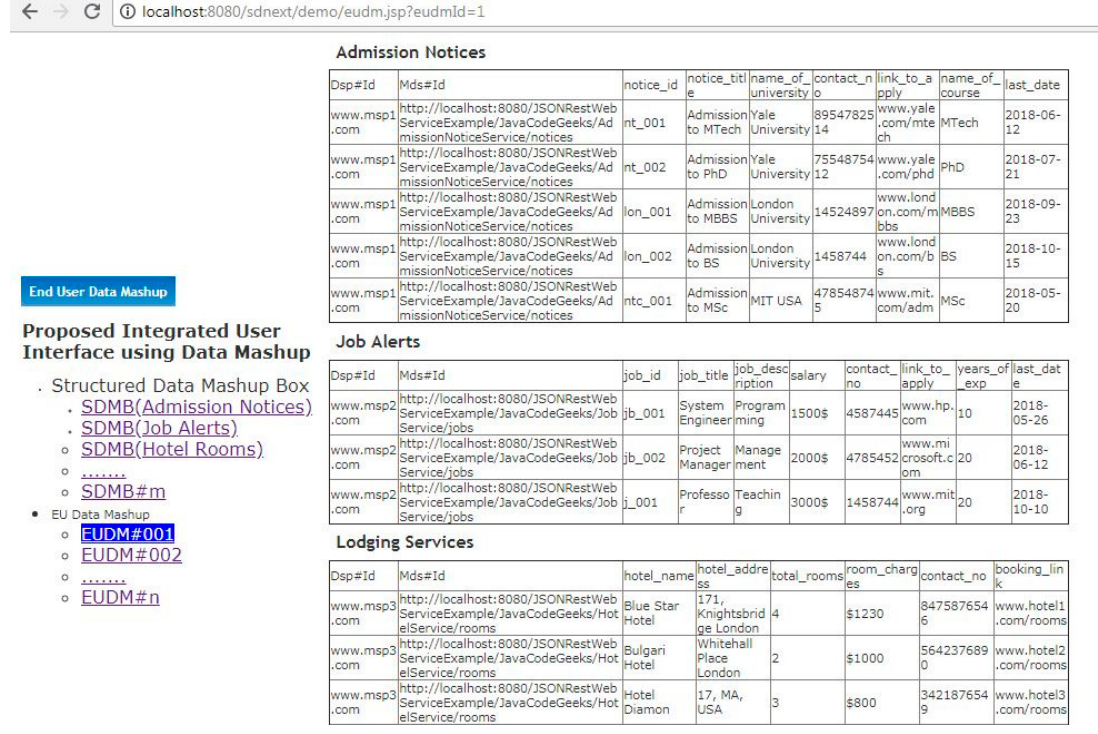
Figure 13. Integrated UI View using EU Data Mashup.